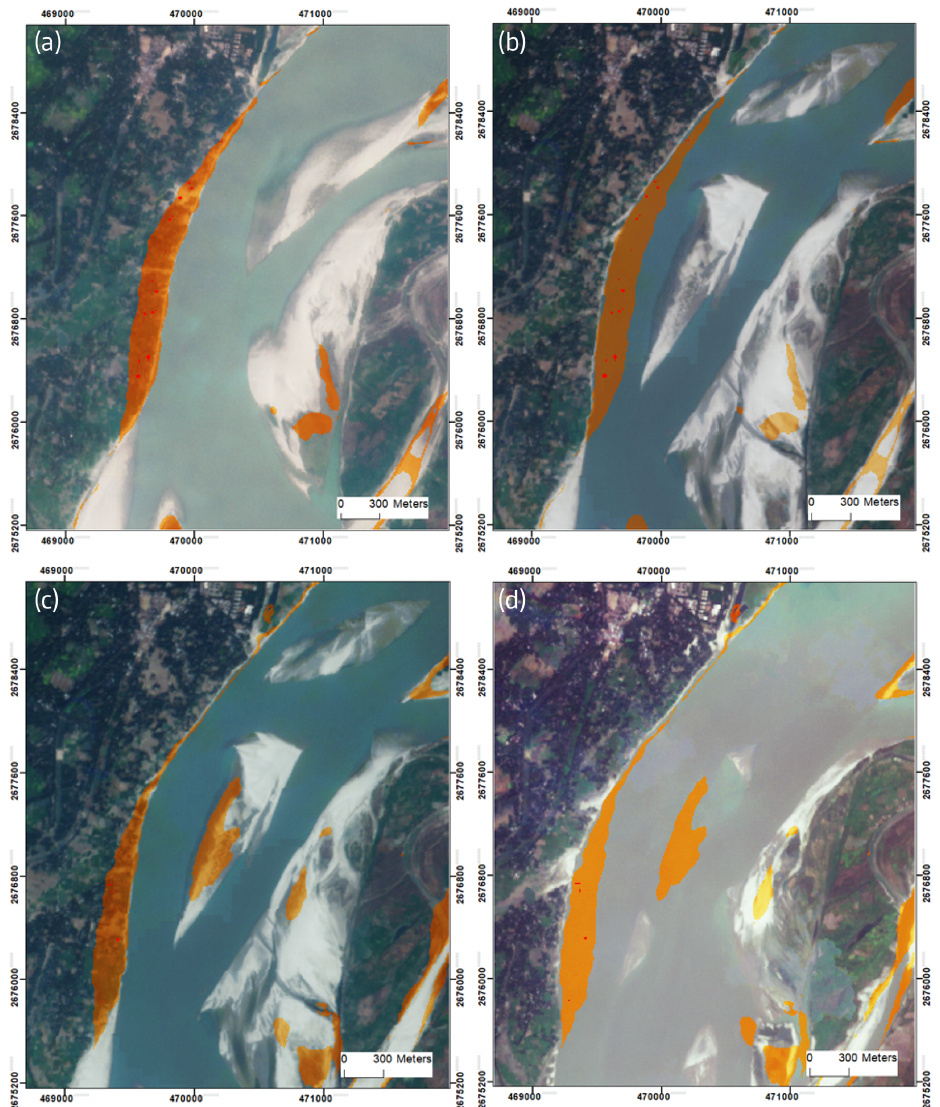
Figure 8. Validation of erosion detection. Shown are eroded land (orange) and eroded settlements (red) for 2018 (a, b) and 2019 (c, d) . Baseline: optical Sentinel-2 images from before (a, c) and after (b, d) the monsoon. The location of the patch is shown in Fig. A1 (patch